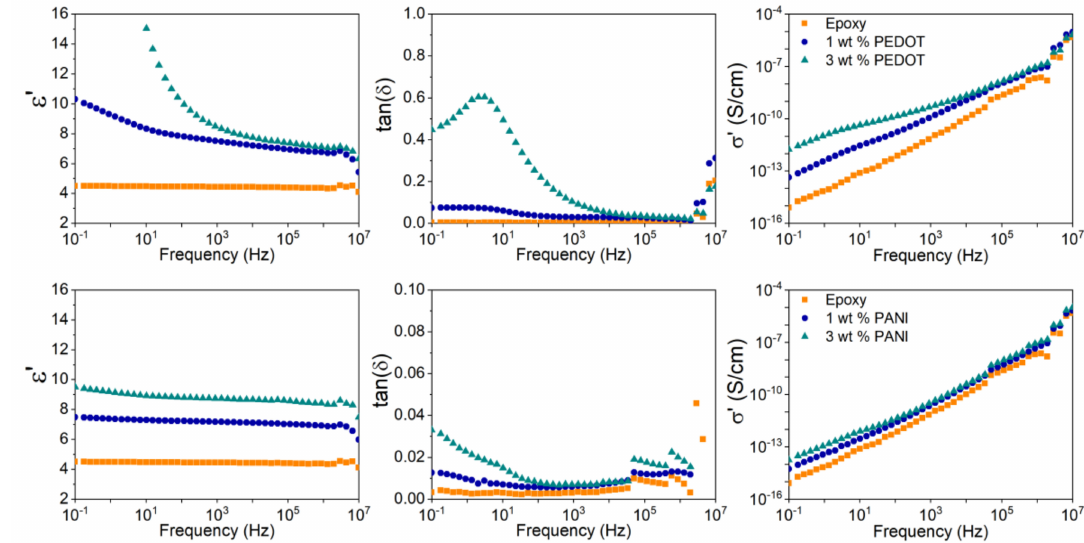
Figure 6. Permittivity ( left ), loss tangent ( middle ), and AC electrical conductivity ( right ) for PEDOT ( up ) and PANI ( down ) filled epoxy